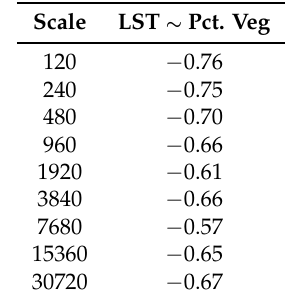
Table 6. The percent of vegetation has a significant negative relationship with LST at all analytical extents. The results are the correlation coefficients between LST and the percent of vegetation for each dominant length scale (calculation